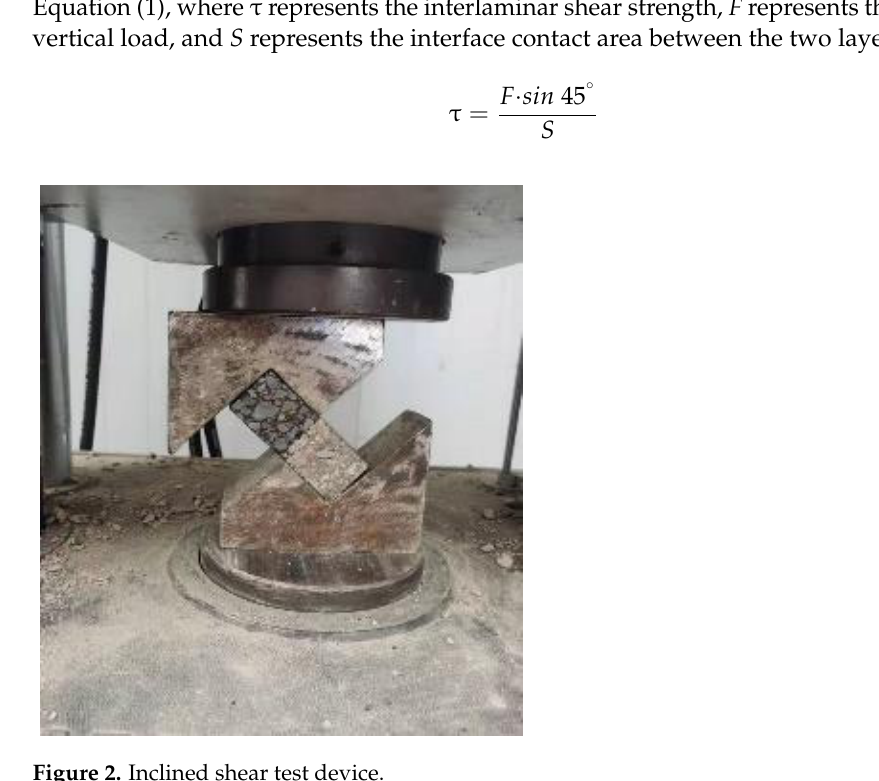
Figure 2. Inclined shear test device.